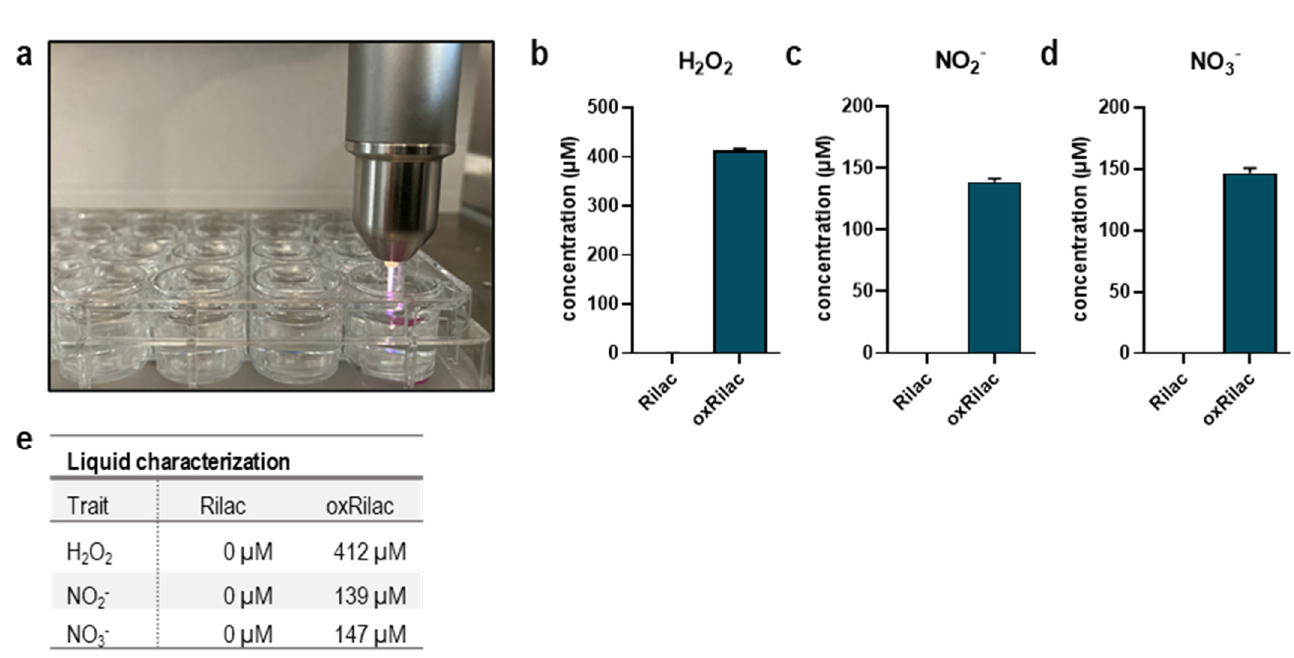
Figure A1. Gas plasma-generated ROS and RNS in Ringer’s solution. ( a – d ) kINPen conductively treating 2 mL of Ringer’s solution ( a ) for 10 min and subsequent H 2 O 2 ( b ), NO 2 − ( c ), and NO 3 − ( d ) production; ( e ) summary table with final concentrations.